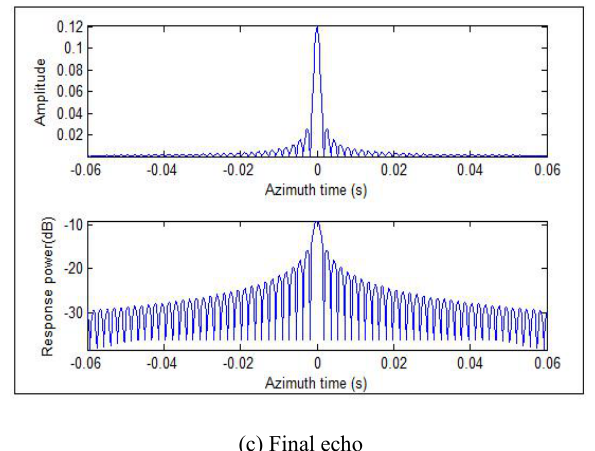
Figure 2. Simulation results of the echoes before and